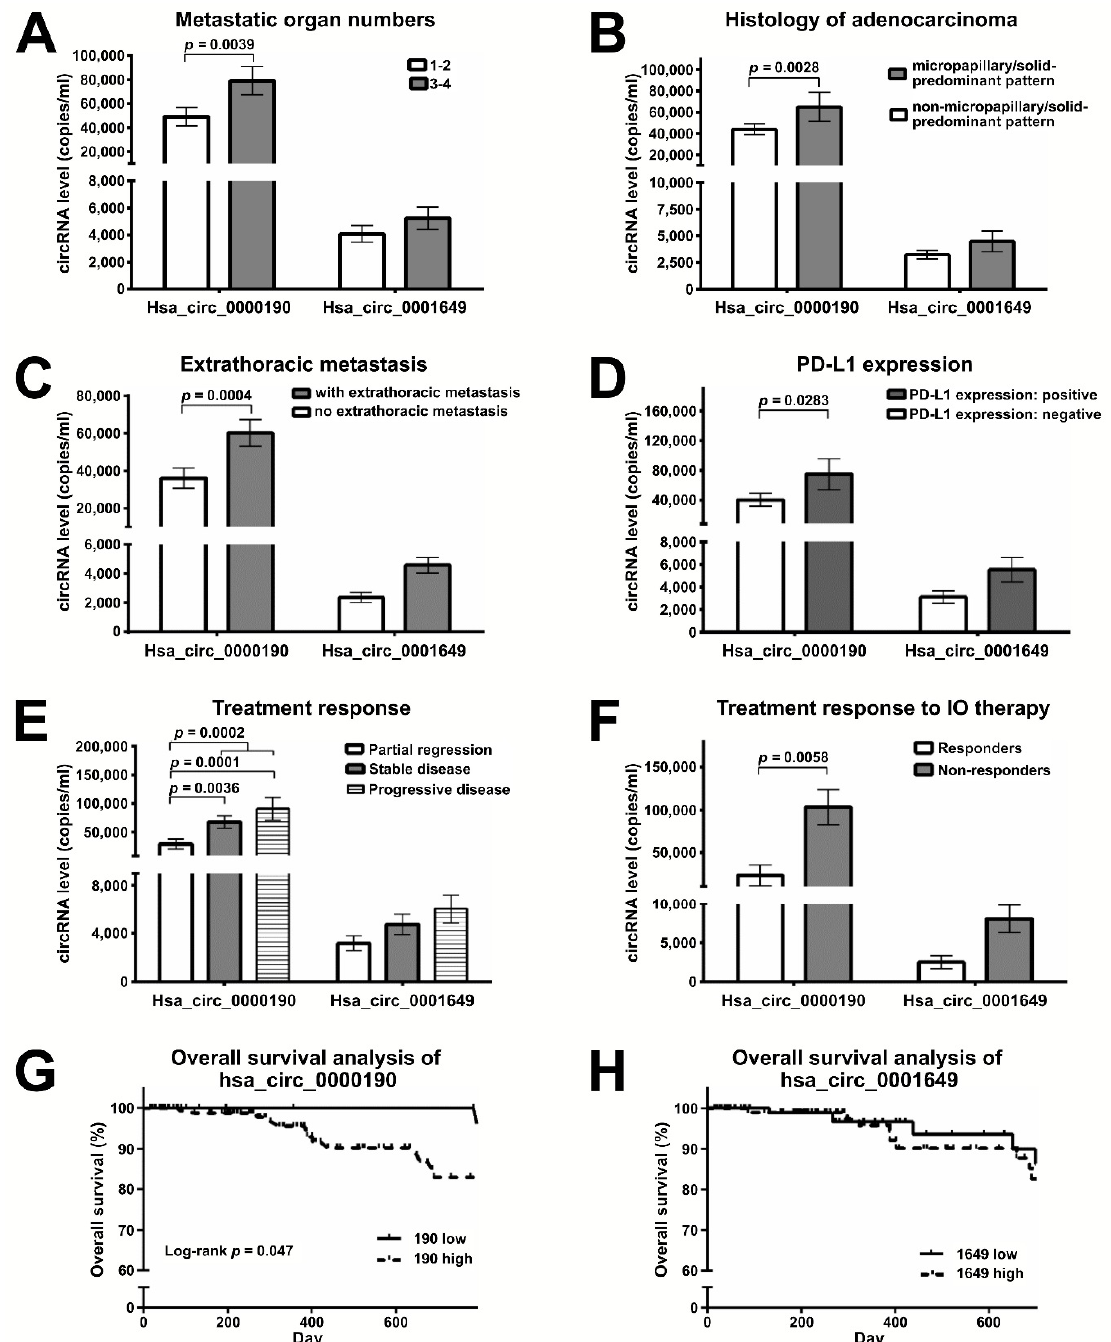
Figure 5. Plasma levels of hsa_circ_0000190 negatively correlate with the response to immunotherapy. ( A – F ) RT-ddPCR analysis comparing the expression of hsa_circ_0000190 and hsa_circ_0001649 in the plasma of lung cancer patient groups with: ( A ) different numbers of metastatic organs (1–2 vs. 3–4 organs); ( B ) micropapillary/solid-predominant histological type vs. other histological types; ( C ) with vs. without extrathoracic metastasis; ( D ) positive vs. negative PD-L1 expression; ( E ) the indicated types of treatment response; ( F ) positive vs. negative response to IO therapy. Mean values are shown with standard deviation error bars, p -value calculated by Student’s t -test. ( G , H ) Survival analysis of patients with high and low expression of hsa_circ_0000190 (G) and hsa_circ_0001649 ( H ).